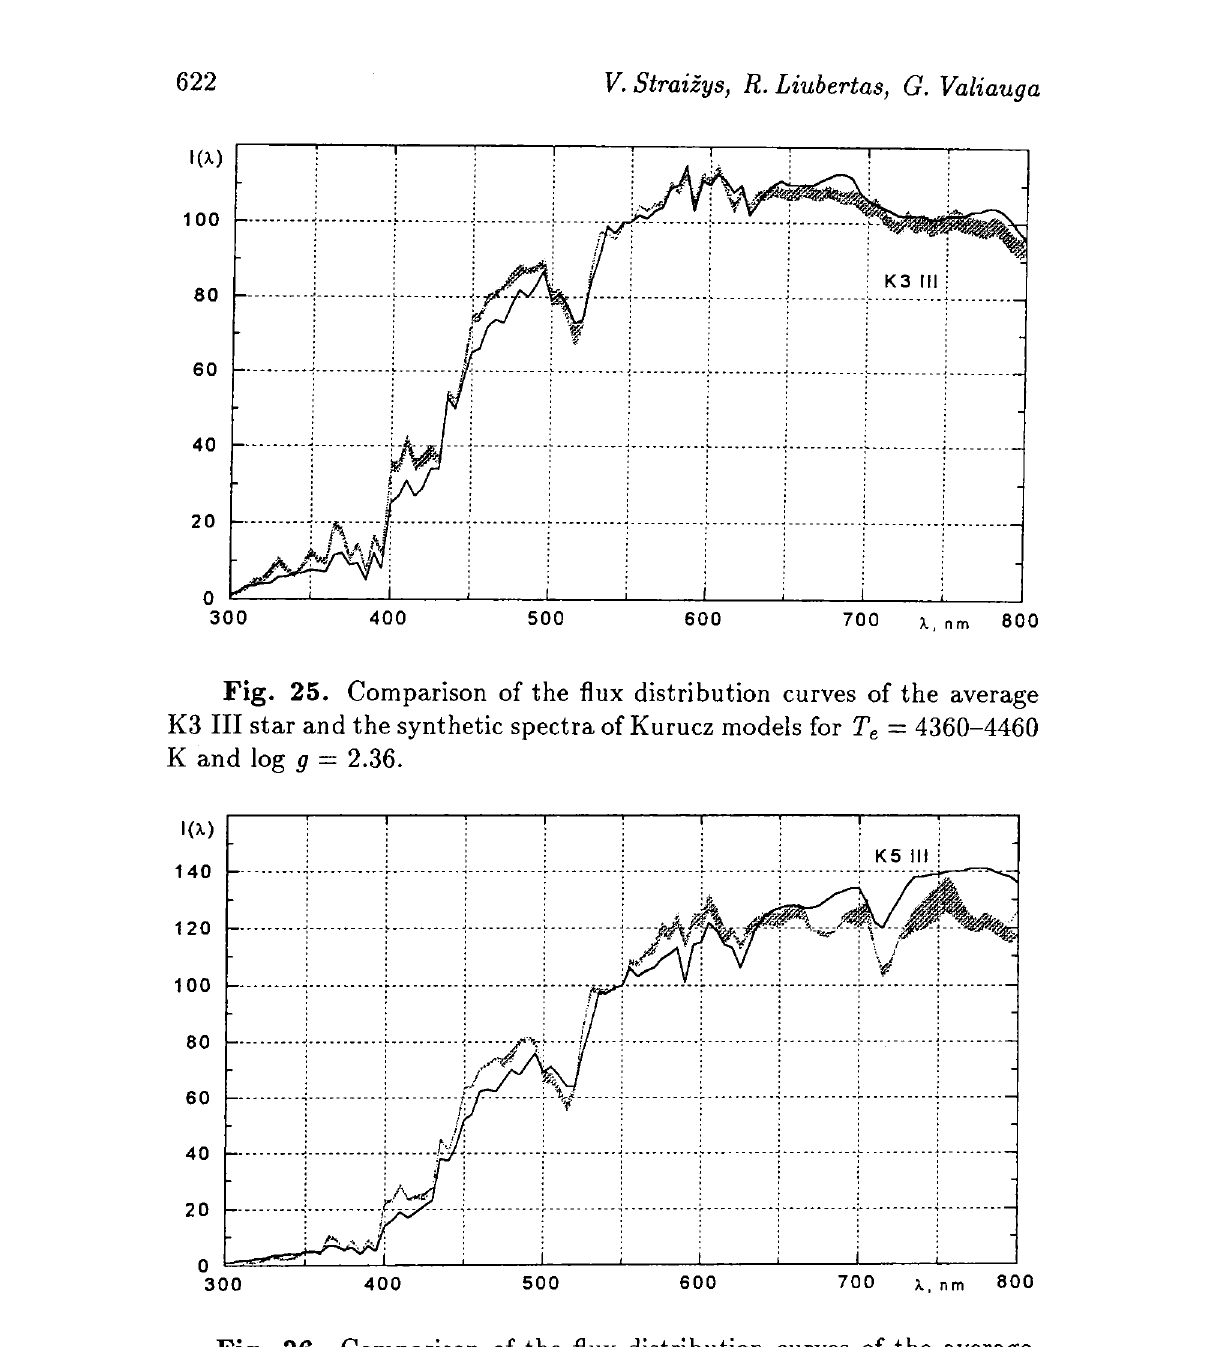
Fig. 26. Comparison of the flux distribution curves of the average K5 III star and the synthetic spectra of Kurucz models for T K and log g =